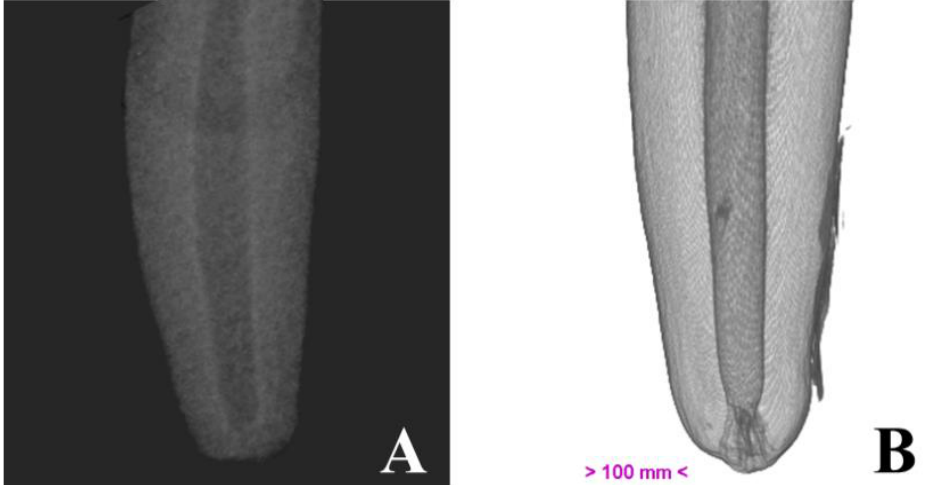
Figure 4. Illustrative image of the canine root, obtained by dental radiography (A) and by micro- computed tomography (B).